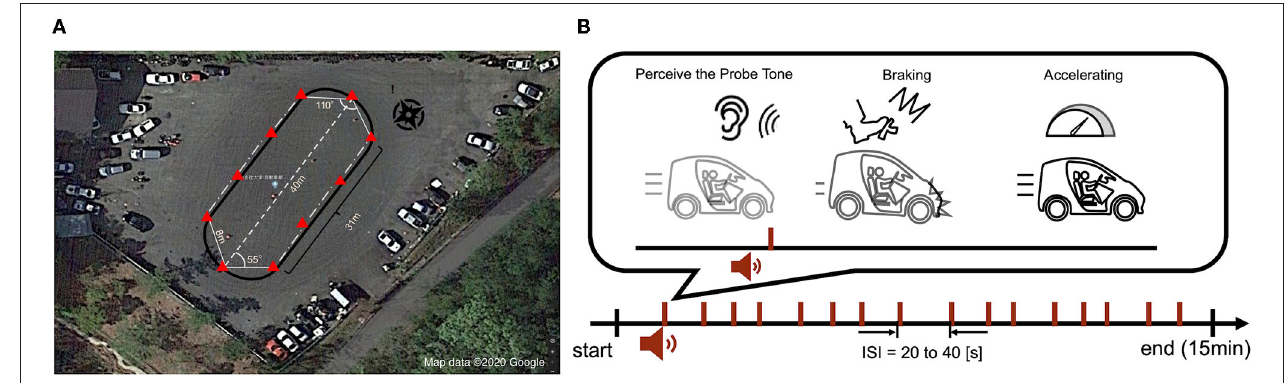
FIGURE 1 | Experimental driving course and design. (A) The experimental course was oval, flat and 40m long. The red triangles in the figure indicate the safety cones placed along the course. (B) Beeping sounds were generated at random intervals during the 15-min experiment (inter-stimulus interval: 20–40s). Participants were required to quickly brake and decelerate to 10km/h speed if they recognized the beeping sound while traveling at 20km/h. After decelerating, they accelerated again and were allowed to continue driving while maintaining a speed of 20km/h.